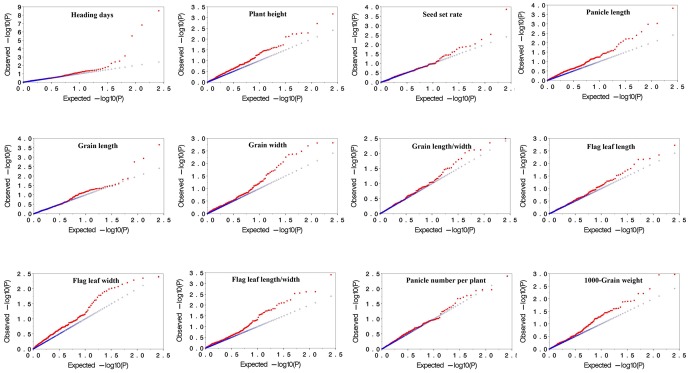
Plots of observed versus expected P-values using MLM (Q+K) model for 12 agronomic traits in 2009.Blue symbol represents expected P-values, and red symbol represents observed P-values.